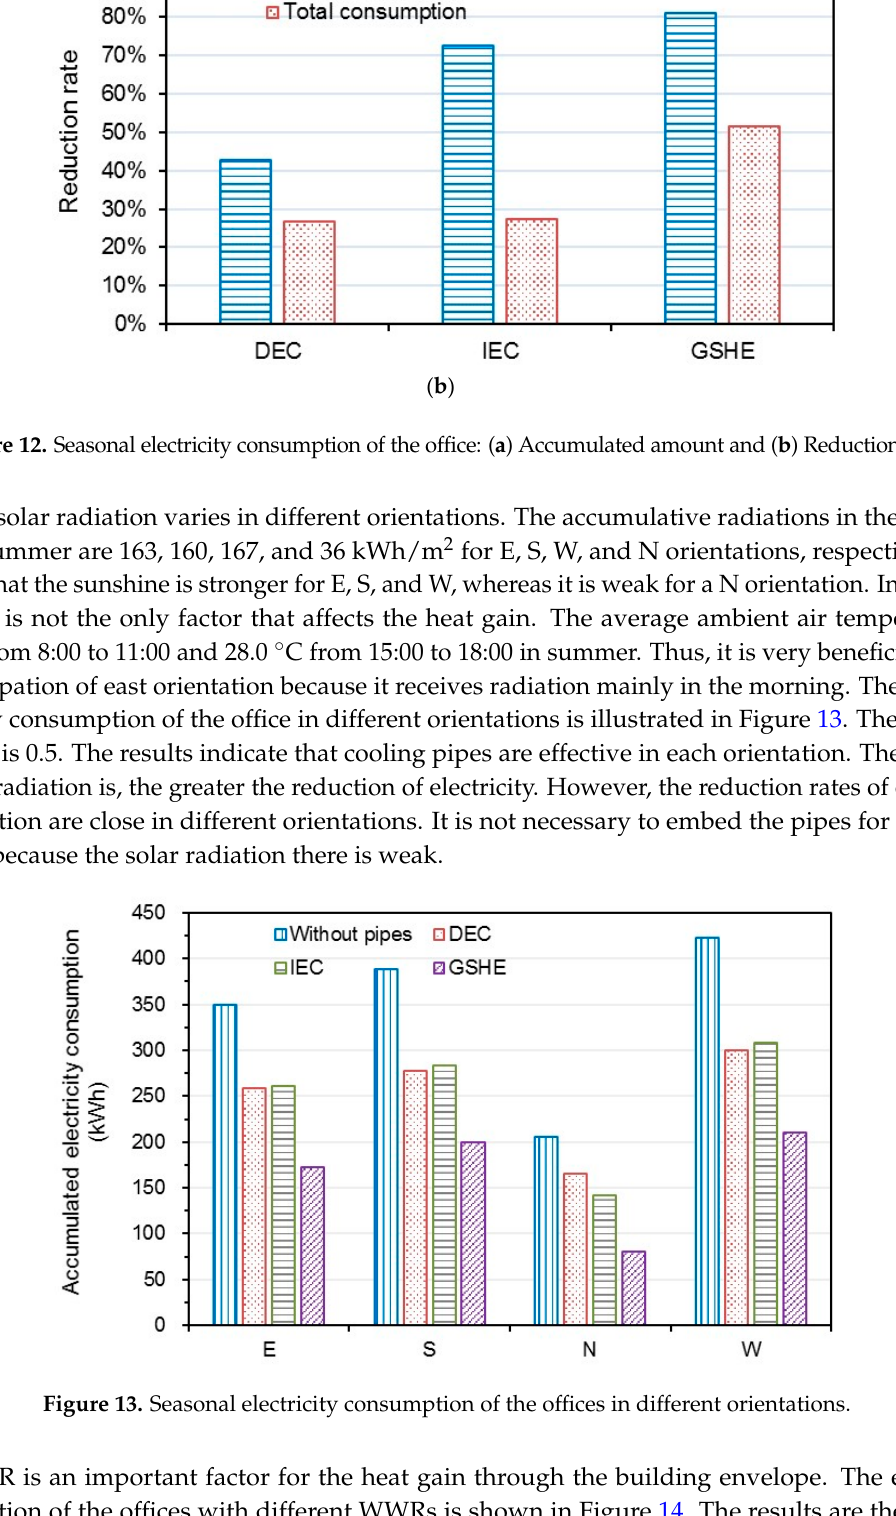
Figure 13. Seasonal electricity consumption of the offices in different orientations.